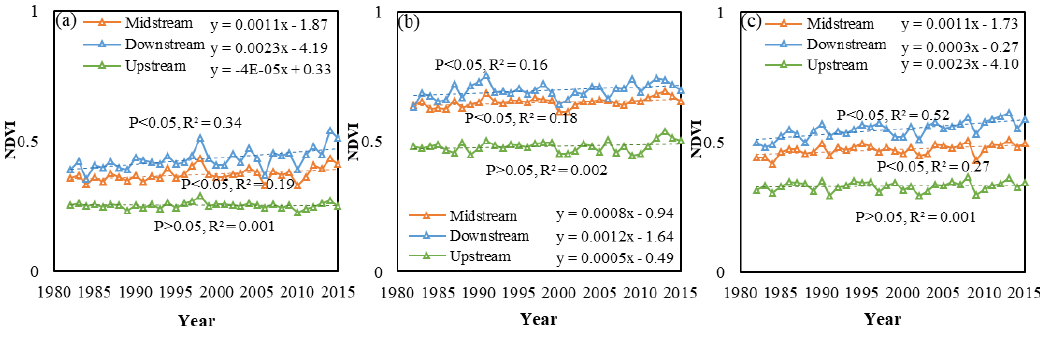
Figure 3. NDVI change in sub-watersheds during different seasons, i.e., ( a ) late spring; ( b ) summer and ( c ) early autumn.